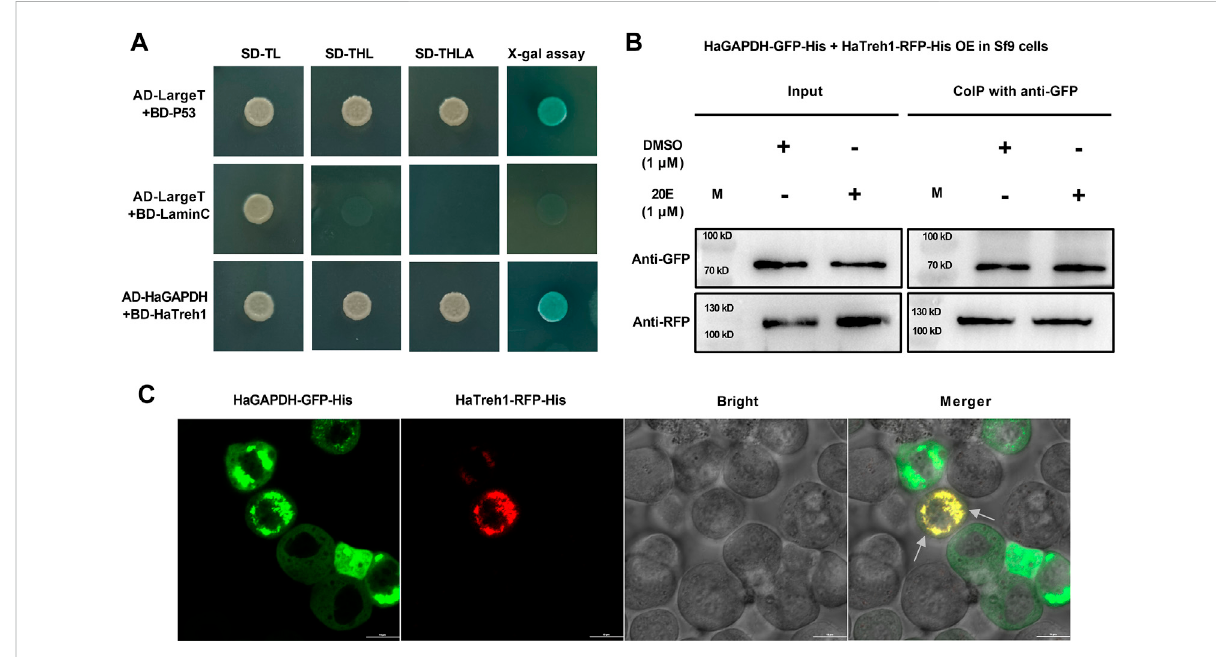
FIGURE 5 HaGAPDH bound to HaTreh1. (A) Y2H demonstrated the direct binding of BD-HaTreh1 and AD- HaGAPDH . AD-LargeT + BD-P53 was the positive control, and AD-LargeT + BD-laminC was the negative control. (B) Co-IP experiment proved the interaction between HaTreh1 – RFP – His (103 kD) and HaGAPDH – GFP – His (74 kD) under the 20E treatment in Sf9 cells. M: protein marker. (C) Colocalization of HaTreh1 – RFP – His and HaGAPDH – GFP – His in Sf9 cells by using the LSM710 microscope. The merger was the overlap of red and green fl uorescence. The arrow indicates the overlapped yellow